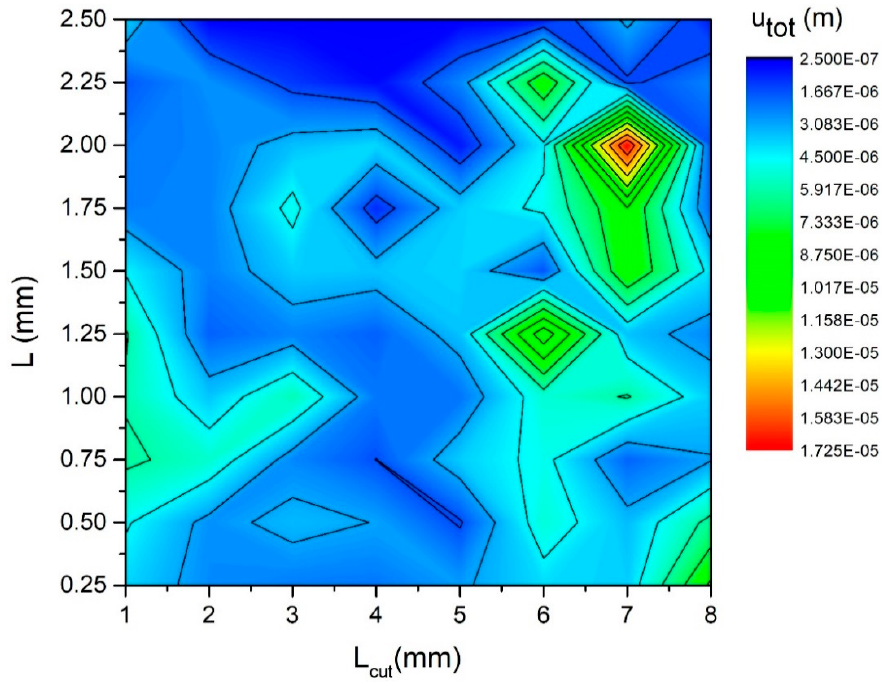
Figure 5. The plot of objective function dependence from design variables.